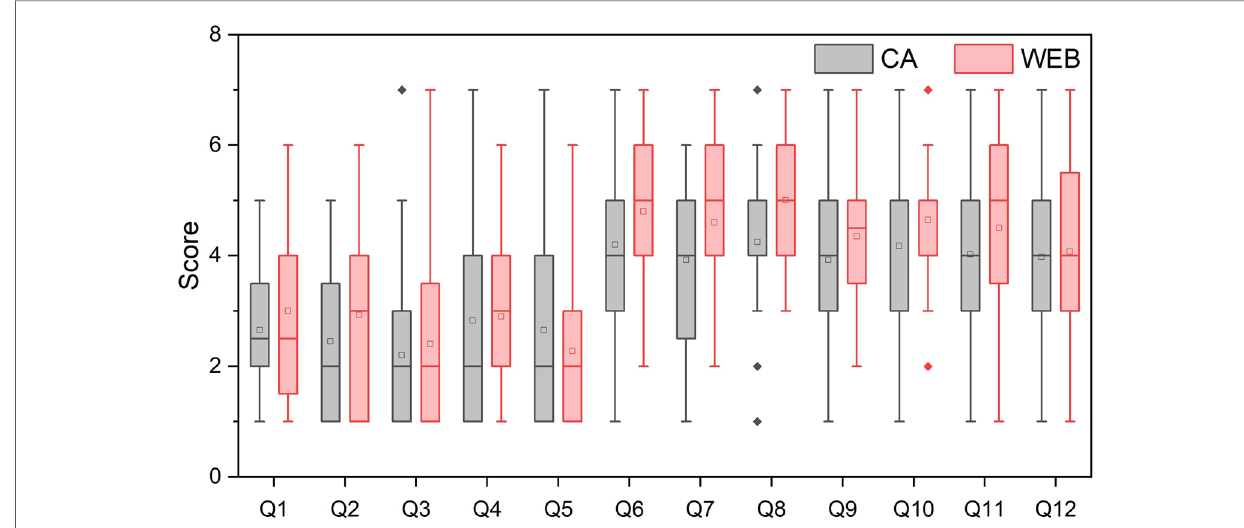
FIGURE 3 Scores of the trust in automation scale items for both study groups. Student ’ s t-test shows signi fi cant difference for Q7 ( The system provides security ): CB: 3.93 ( SD ¼ 1 : 58), WEB: 4.6 ( SD ¼ 1 : 34), t ¼ (cid:2) 2 : 07, p ¼ 0 : 042, Cohen ’ s d ¼ 0.46, and Q8 ( The system has integrity ): CB: 4.25 ( SD ¼ 1 : 46), WEB: 5 ( SD ¼ 1 : 18), t ¼ (cid:2) 2 : 53, p ¼ 0 : 014, Cohen ’ s d ¼ 0.57. As the performed t-tests were independent of each other, there was no need for Bonferroni